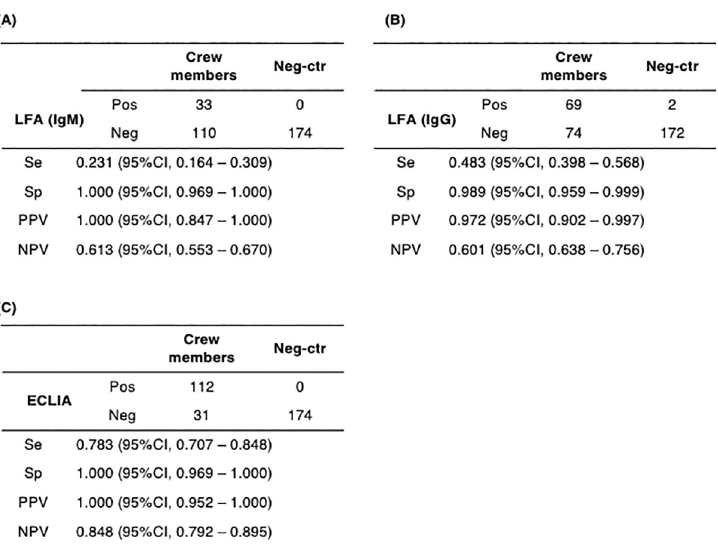
Fig 2. Performance of LFA and ECLIA in detecting anti-SARS-CoV-2 antibodies. Anti-SARS-CoV-2 IgM (A) and IgG (B) antibodies were detected using a lateral flow immunochromatographic assay (LFA), and anti-SARS-CoV-2 total antibodies were detected using an electrochemiluminescence immunoassay (ECLIA). Blood samples were collected from cruise ship crew members who had positive results from the first SARS-CoV-2 genetic testing 3–4 weeks before blood collection. Neg-Ctr, blood samples for negative controls that were collected from patients at Nagasaki University Hospital between November 2014 and August 2019; Se, sensitivity; Sp, specificity; PPV, positive predictive value; NPV, negative predictive